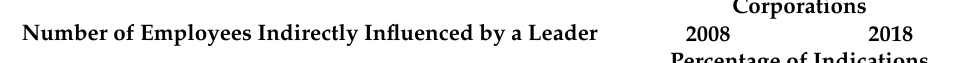
Table 2. Number of employees under a leader’s indirect influence as assessed by leaders of the Forbes Global 2000 world’s largest